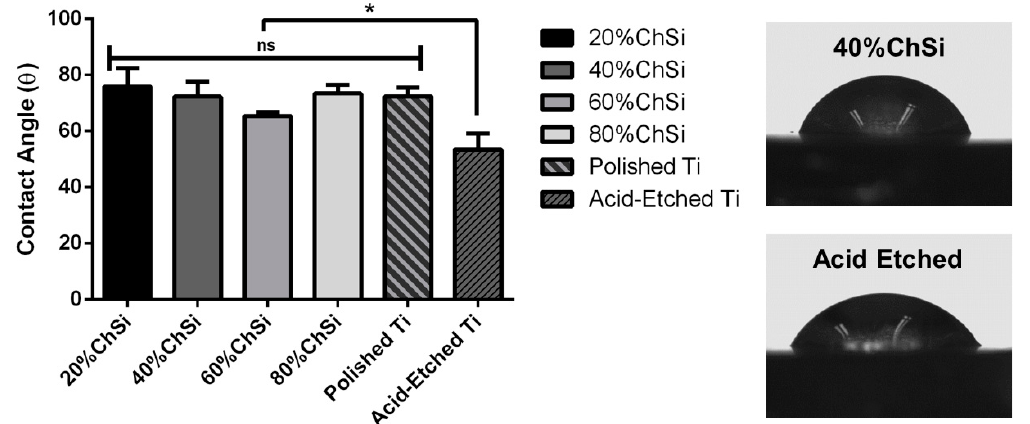
Figure 8. Water contact angles for coatings and titanium (Ti6Al4V) substrates. Static water contact angles ( n = 5/surface) for all coatings and polished Ti6Al4V were similar with an intermediate degree of hydrophilicity. Contact angles for acid-etched Ti6Al4V were significantly ( p < 0.05) lower and more hydrophilic. ns—not significantly different; *—statistically significant different.